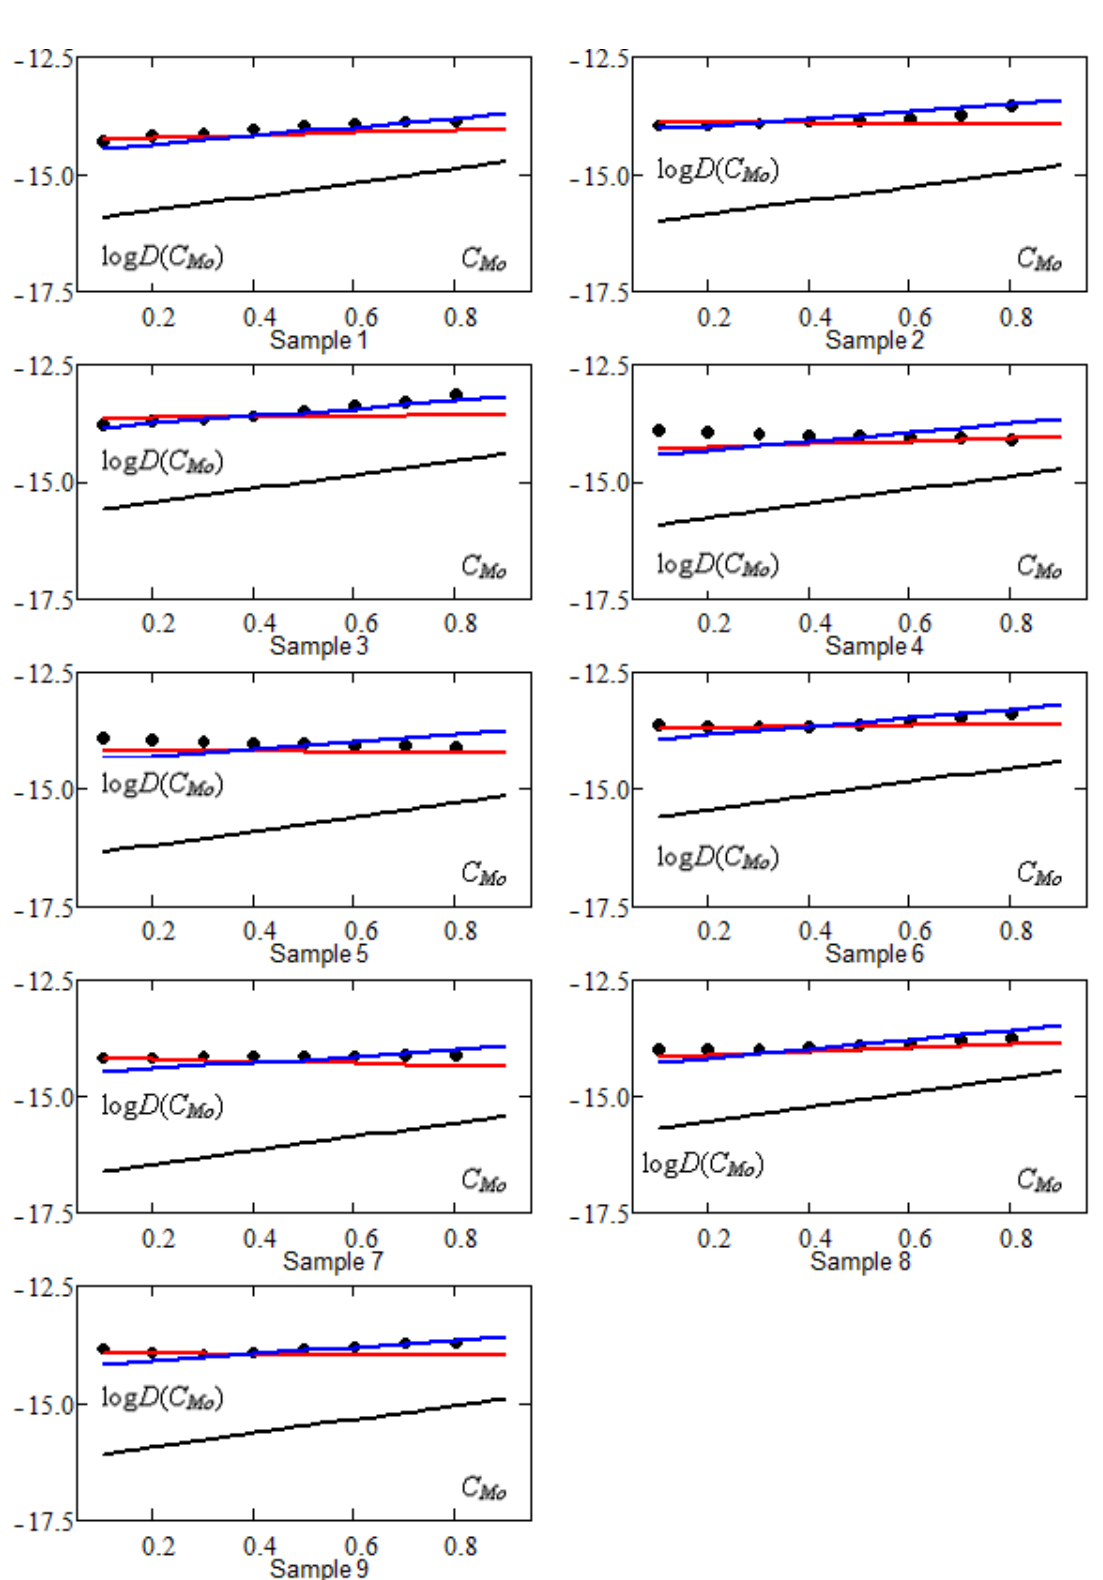
Figure 2. The lower line in each plot corresponds to the calculation of logarithms of the coefficients of thermally activated diffusion from the formula (1). The blue line was obtained by calculation